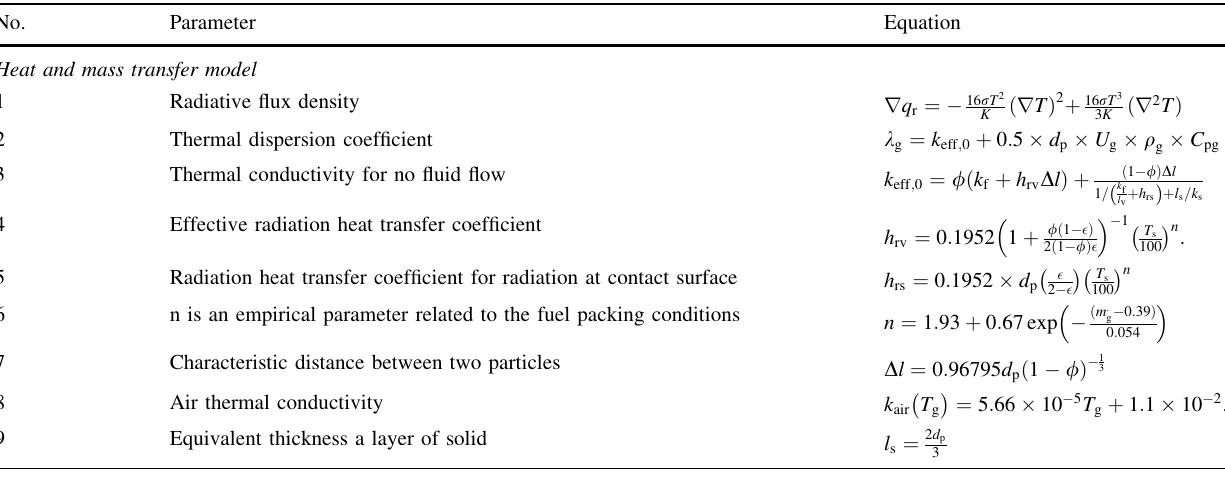
The Burn cell is a reactor based on the principle of Gibbs free energy minimization. Both chemical equilibrium and phase equilibrium can be calculated simultaneously. The unit is used to simulate the gasification layer and com- bustion layer in the fixed bed gasifier. The components contained in C, H, O, N, S are as follows: H COS, etc.